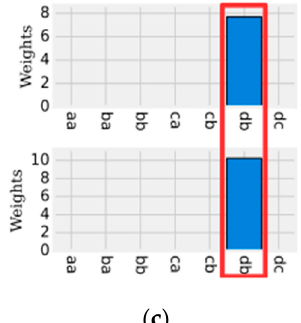
Figure 15. Example of the steps of histograms manipulation based on the SFA-W ( a ); bigrams ( b ); Chi-Squared ( c ). Note: the value 50 indicates the size of the window [25].